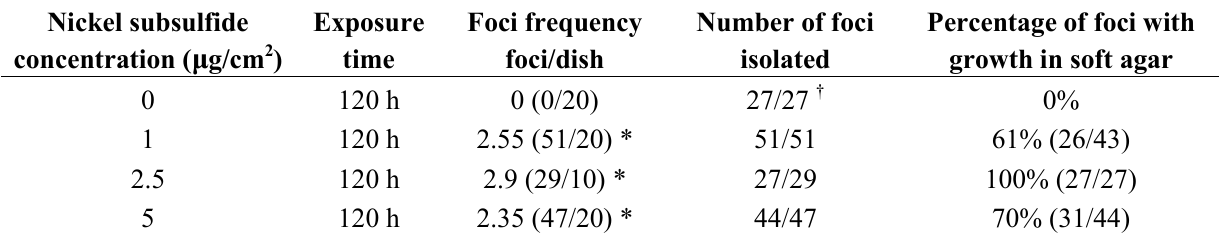
Table 2. Transformation of human lung epithelial cells by nickel